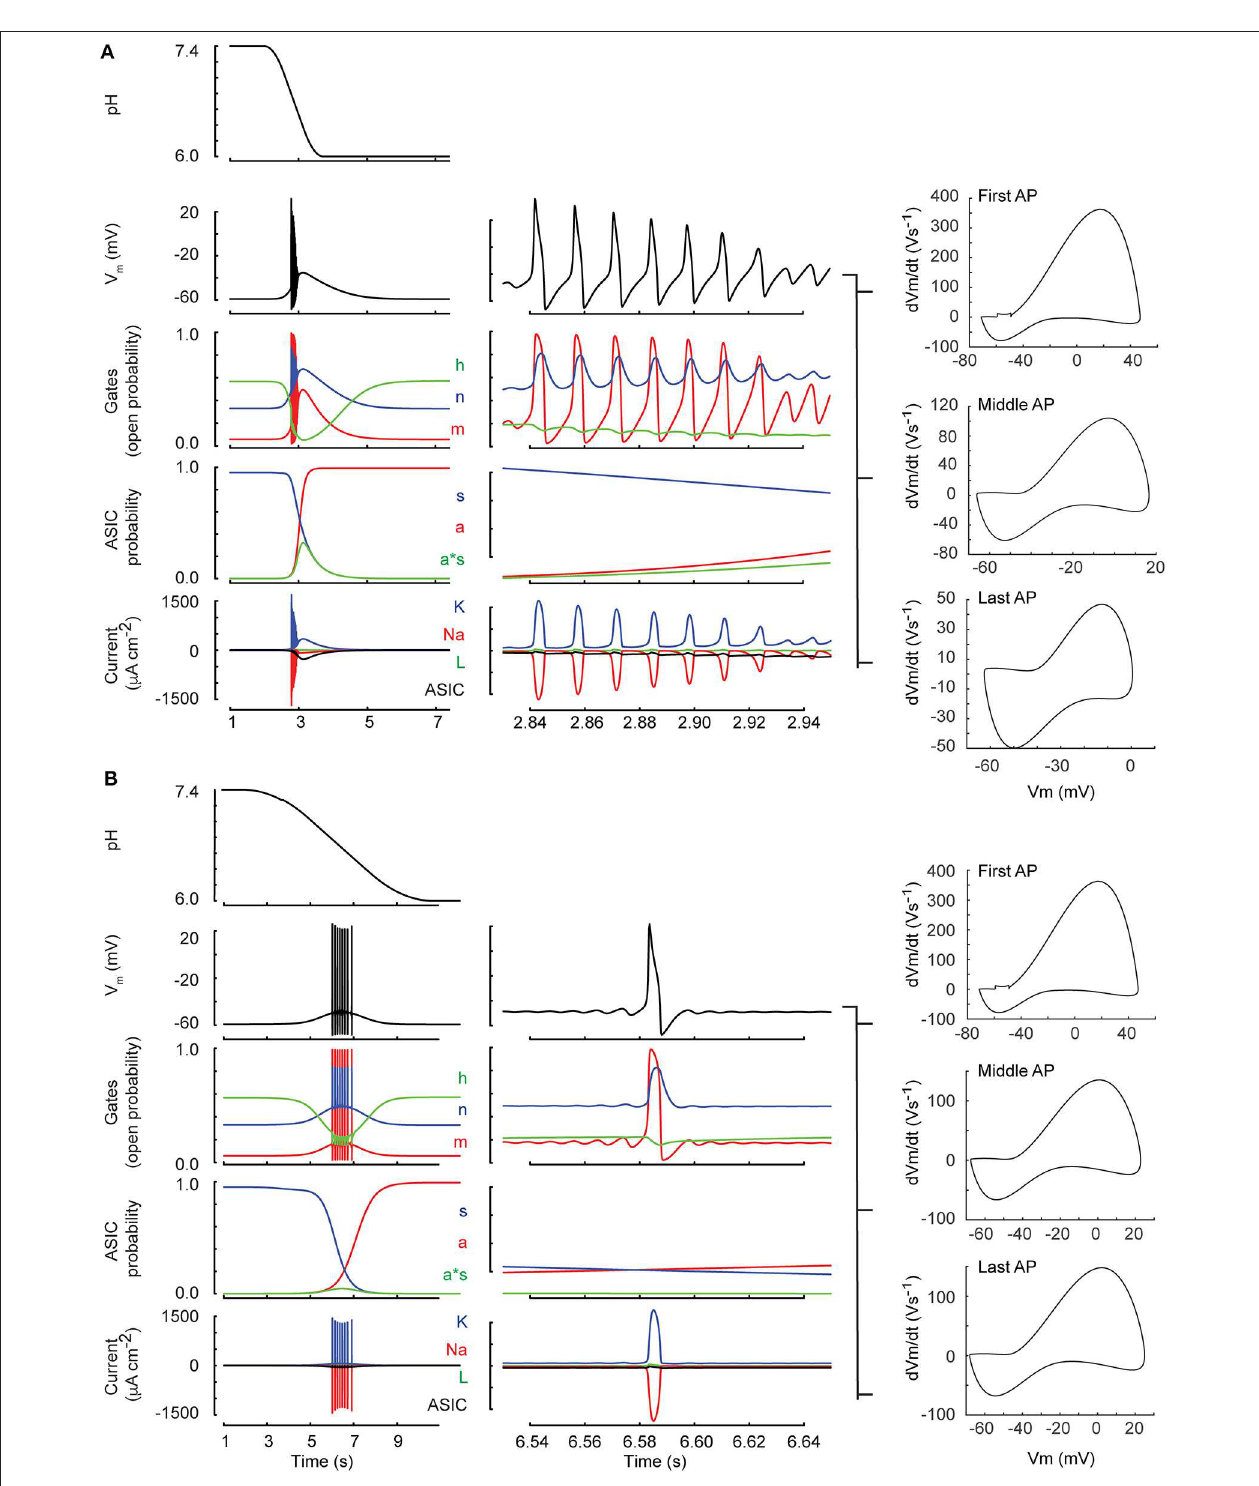
FIGURE 5 | Neuronal model behavior (classical Hodgkin-Huxley model). Shown are two simulations of the neuronal response to a pH drop to pH 6.0 of 1 (A) resp. 6s duration (B) . The center column shows a zoom of 120ms duration selected toward the middle of the firing. From top to bottom, the figures present the time course of the pH, the membrane potential (V m ), the open probabilities of the gates m, h, and n (see Materials and Methods, section Incorporation of I ASIC1a into the Hodgkin-Huxley Model of the Nerve Action Potential), the ASIC behavior in terms of activation of the activation (a) and the sensitization gate (s), and of the product a · s, and the current related to the voltage-gated sodium (Na) and potassium (K) channels, the leak current (L), and the ASIC-mediated sodium current (ASIC). For both ramp types, phase-plane plots of the first AP, an AP in the middle and the last AP of the burst are shown in the right column.